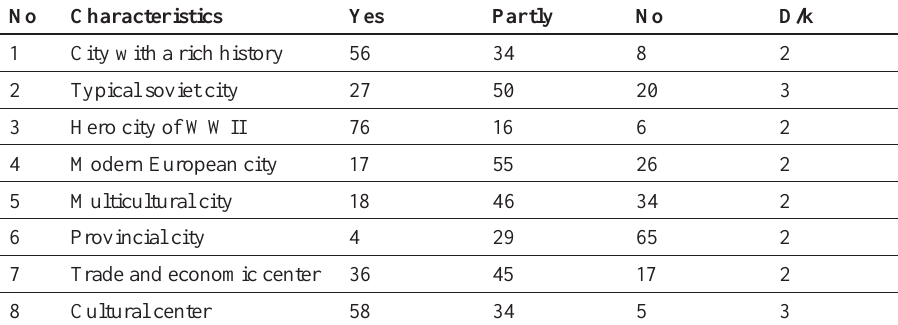
Table 3. What is applicable to the characteristic of Minsk from the